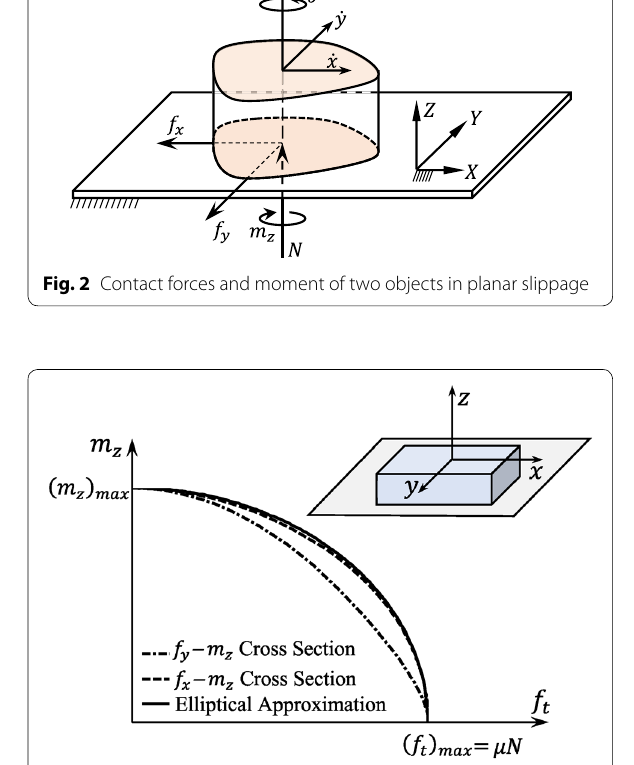
Fig. 3 Cross section view of friction limit surface for a rectangular contact interface